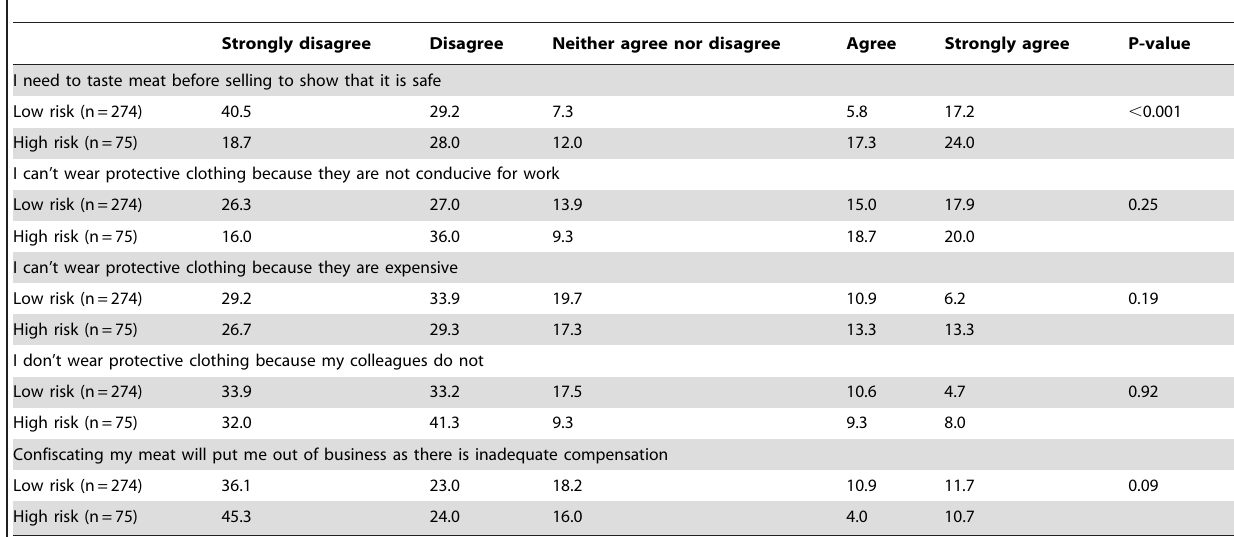
Table 6. Perceived barriers to prevention (values are